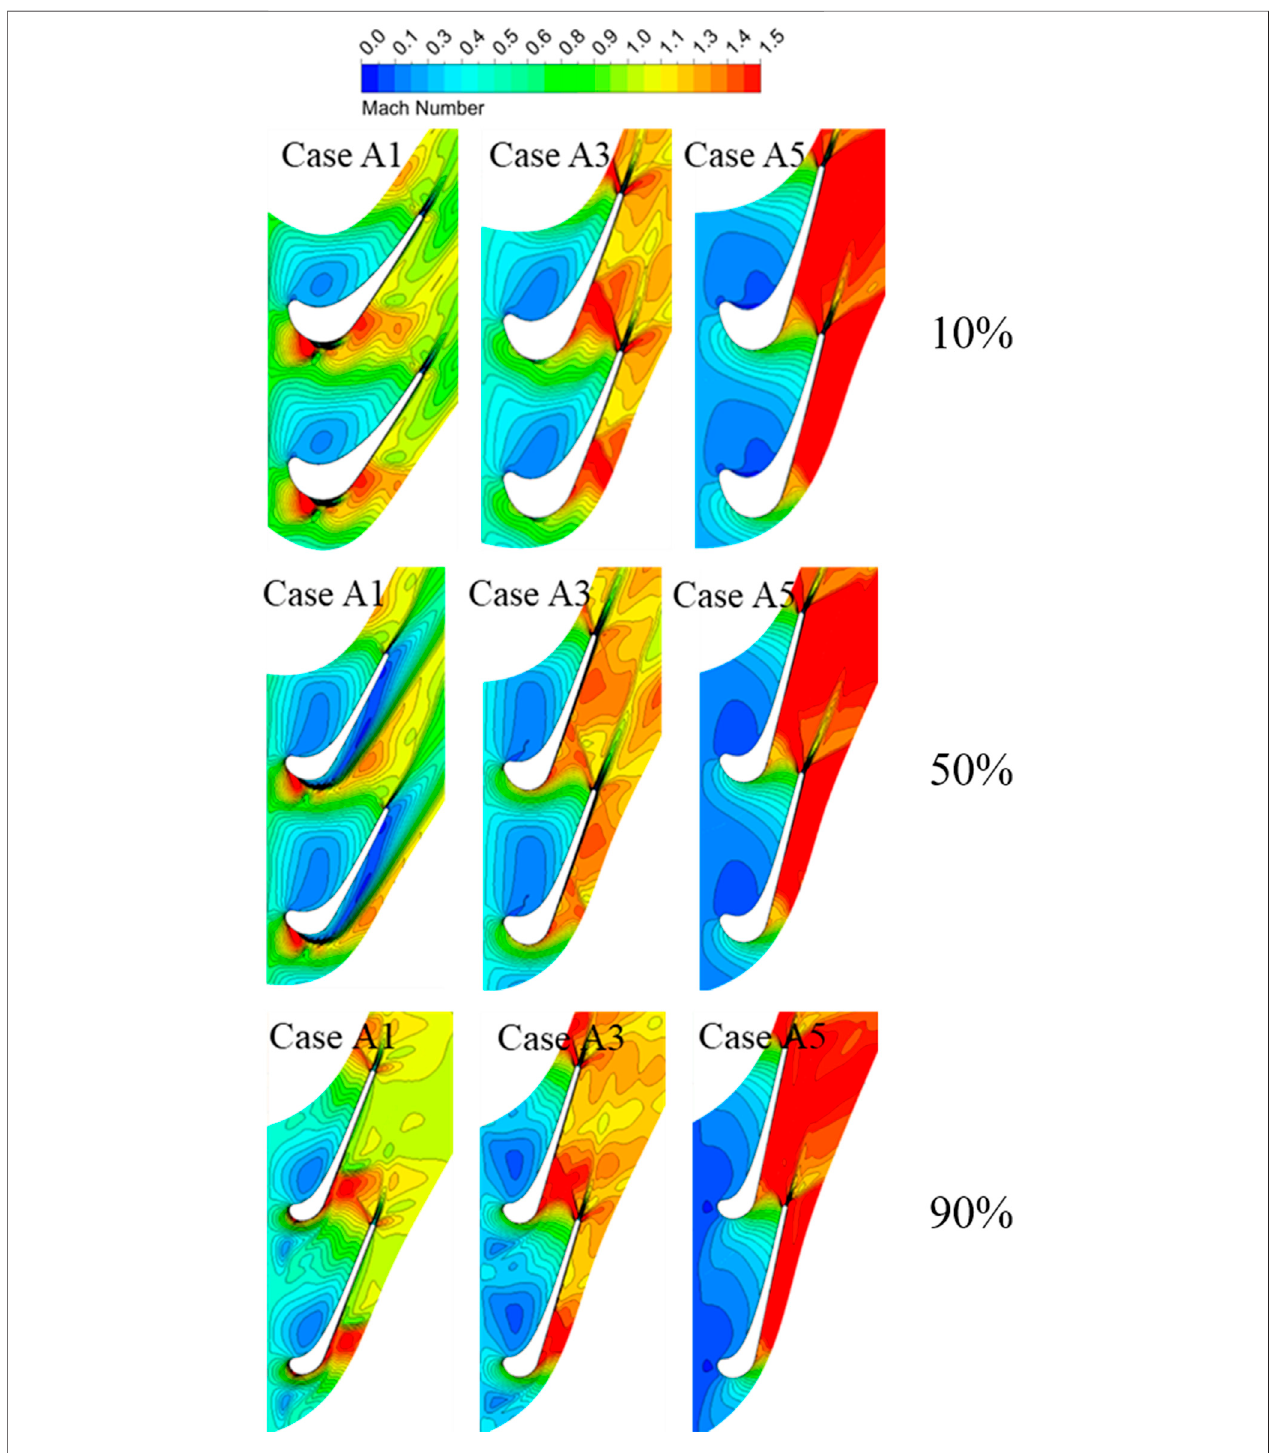
FIGURE 12 | Mach number distribution of rotors for different